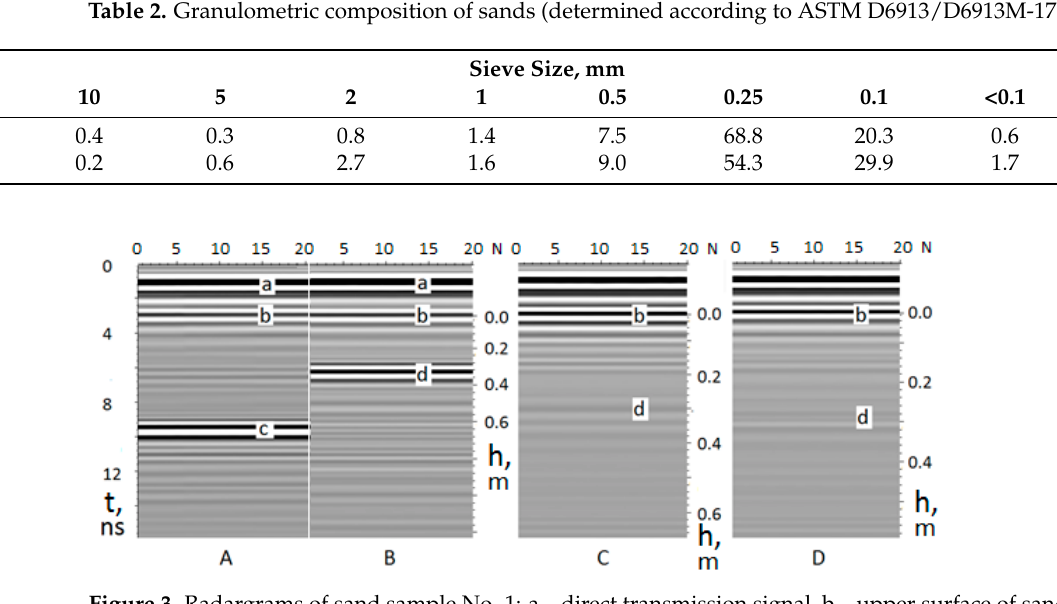
Figure 3. Radargrams of sand sample No. 1: a—direct transmission signal, b—upper surface of sand, c—lower surface of sand, d—waterproof partition. ( A , B ) Sand in a naturally dry state; ( C , D ) sand after moistening with 15.1 L of water and 50 h after moistening. N numbers the traces, t is time, and h is the depth of the sand layer. The timescale shown on the left applies to all radargrams. The change in the depth scales shown to the right of the radargrams reflect the time dependence of relative permeability of moistened sand during water drainage.